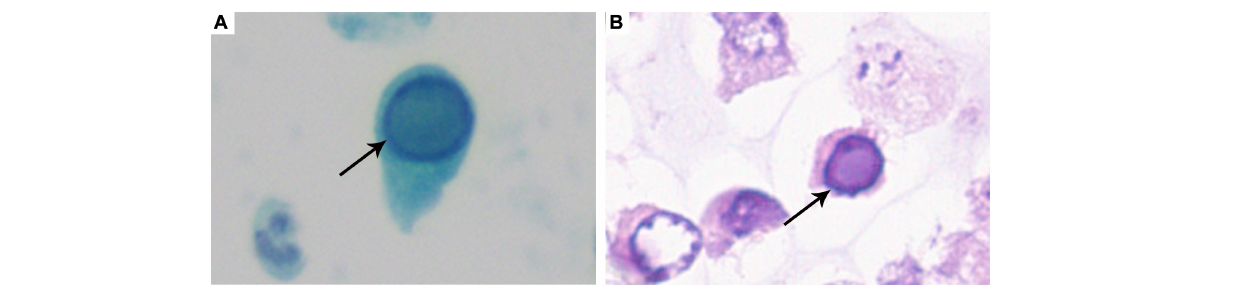
FIGURE 1 | Typical decoy cell. (A) Decoy cell detected by Papanicolaou staining (arrow, × 1,000). (B) Decoy cell detected by Hematoxylin-Eosin staining (arrow, ×